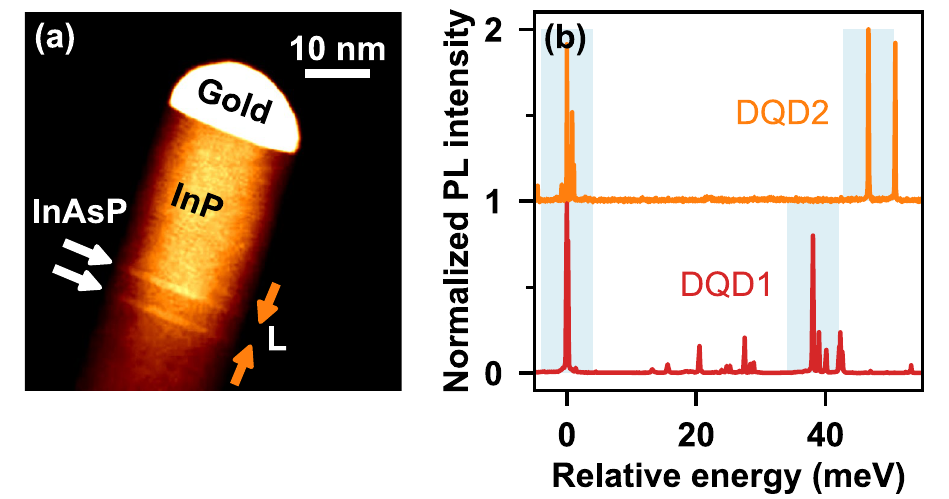
Figure 1. ( a ) Transmission electron microscopy image of a double dot nanowire where the spacer was grown for 5 seconds. White arrows indicate dots, orange arrows indicate inter-dot distance, L . ( b ) Normalized emission spectra of two double-dot wires for two different inter-dot distances. The low-energy s-shell peaks have been aligned to emphasize the relative energy of exciton emissions for these two cases. The s-shell X highlighted by light blue